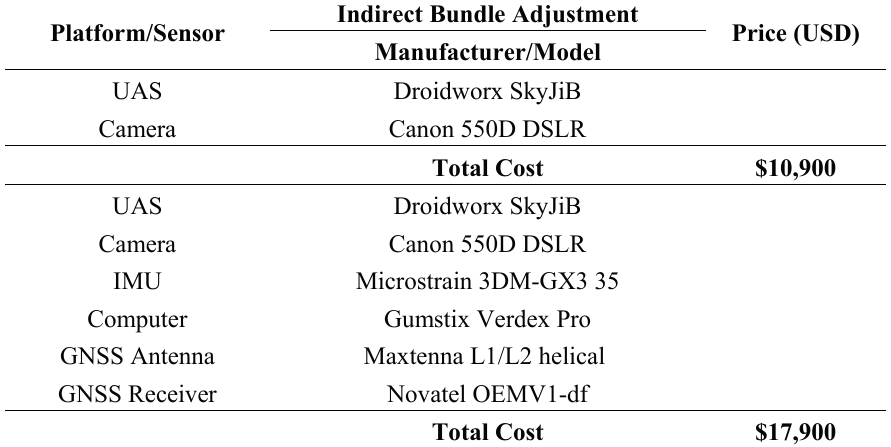
Table 1. Price comparison listing of the components used in this